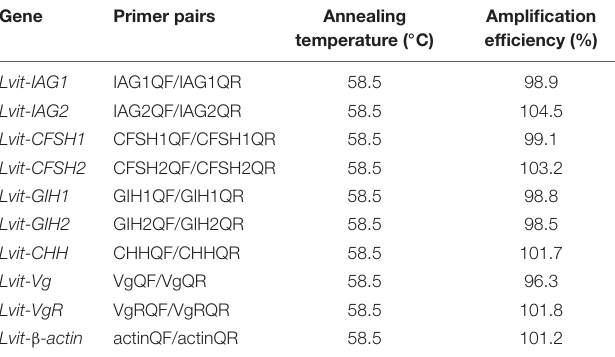
TABLE 3 | Summary of qPCR efficiency of the primer